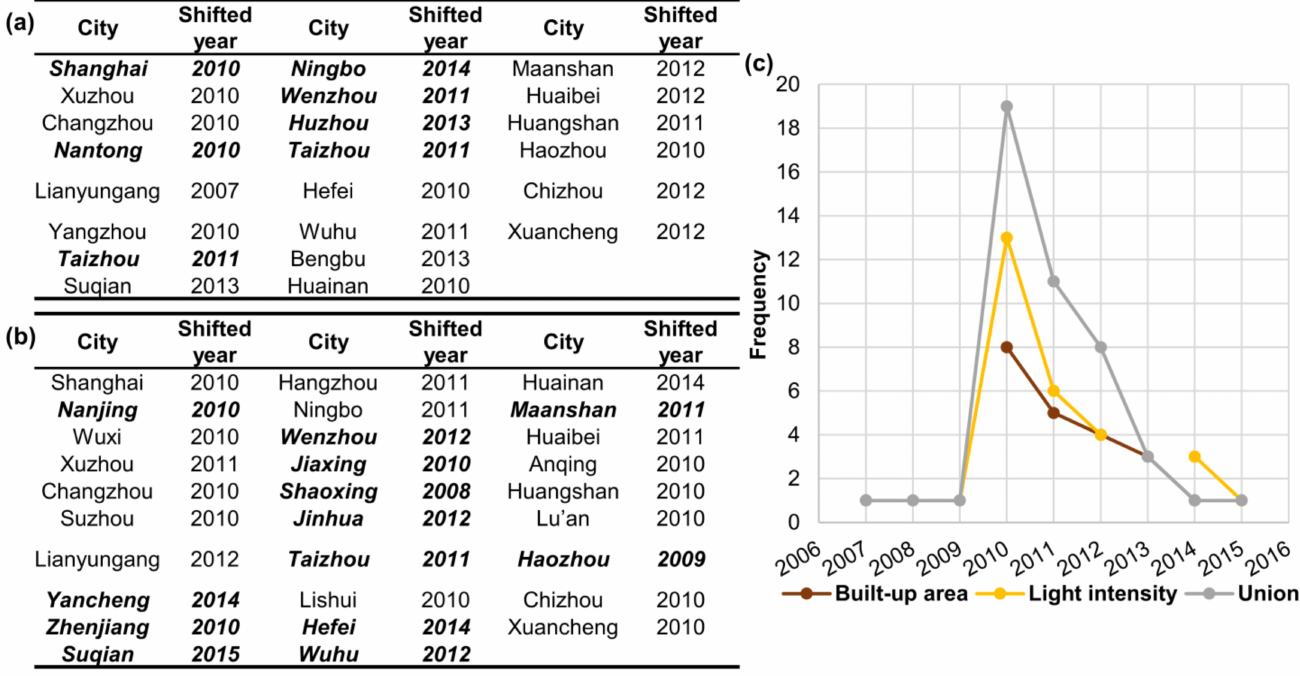
Figure 7. Cities in the Yangtze River Delta: Statistics of tendency shift of the years with significant (95%) confidence: ( a ) built-up area change and ( b ) averaged nighttime light intensity change calculated by the Pettitt’s method; ( c ) related histogram of the tendency shifted years and hotspot cities in 2011–2019 are highlighted in bold (see also Figures 5d and